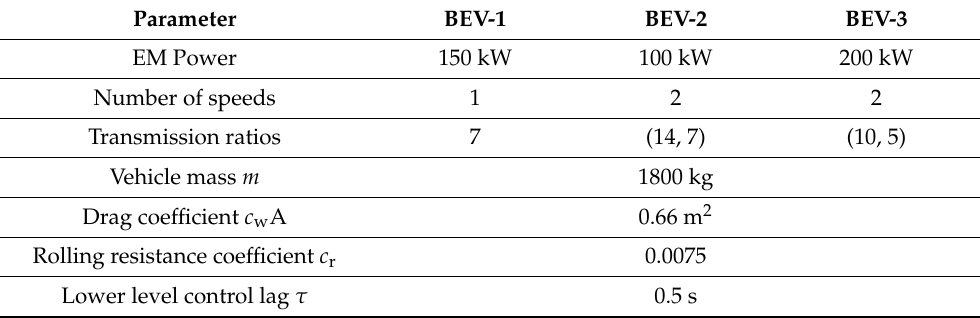
Table 3. Vehicles derived from the powertrain architecture for the experiments.